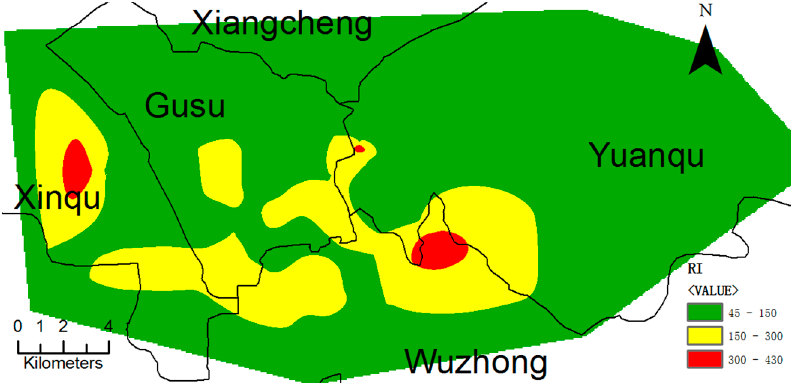
Figure 3. Spatial Distribution of the risk index (RI) in Suzhou soils.